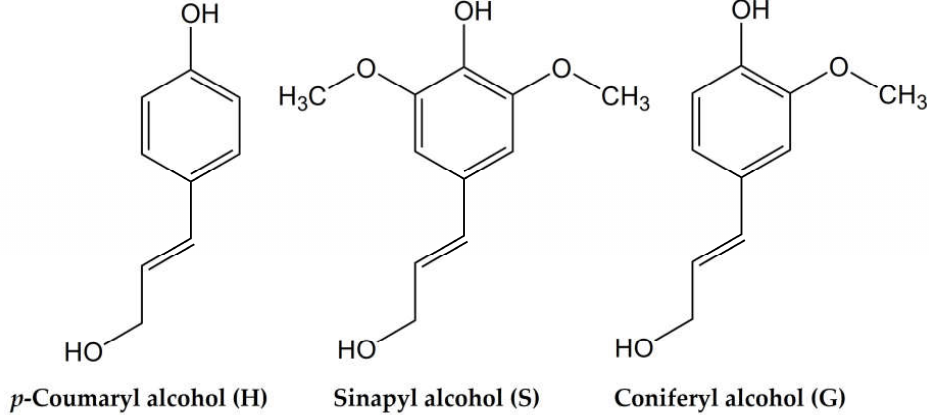
Figure 1. Structures of lignin monolignol